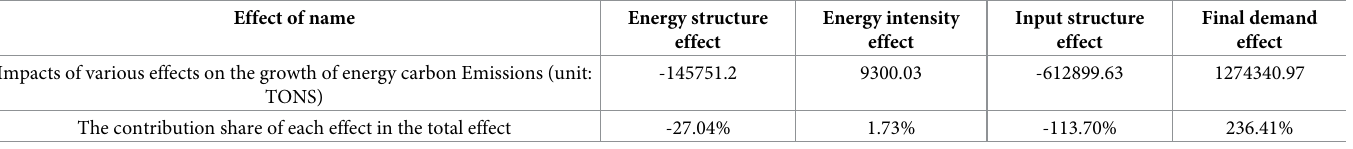
Table 1. Decomposition results of the four-factors from 2007 to